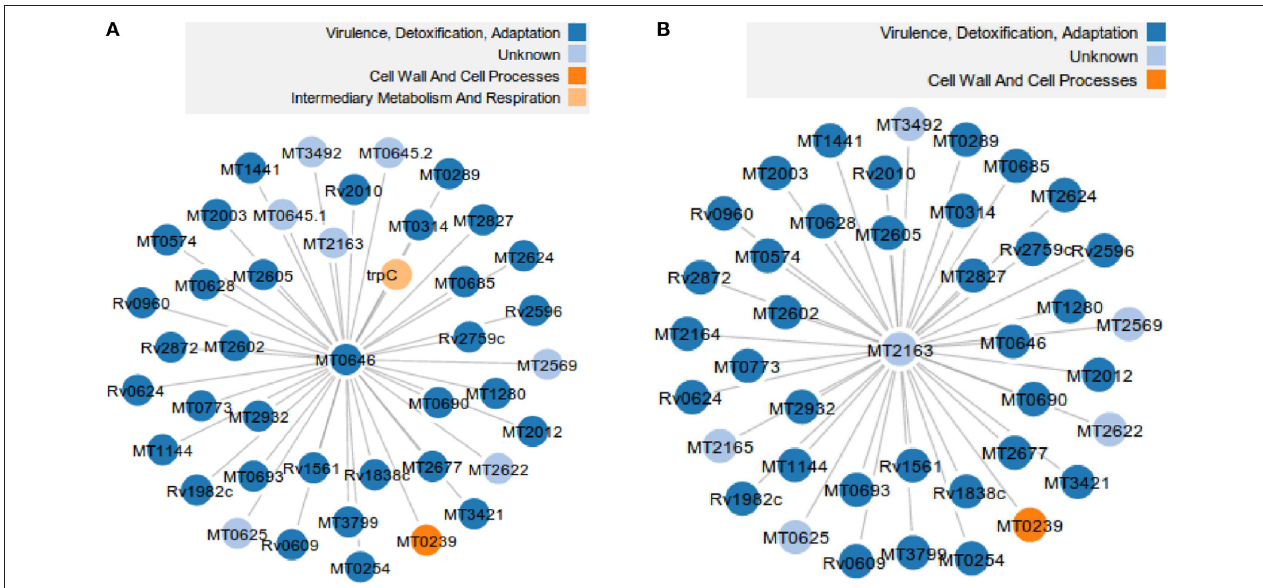
FIGURE 1 | Two out of 59 hub proteins and their 80 neighbors in the MTB network that have been deleted/have no orthologs in MLP. (A) The probable ribonuclease hub protein “O07760” (MT0646) in MTB and its 40 neighbors absent from MLP. (B) The putative uncharacterized hub protein “Q7D7I7” (MT2163) in MTB and its 40 neighbors absent from MLP.